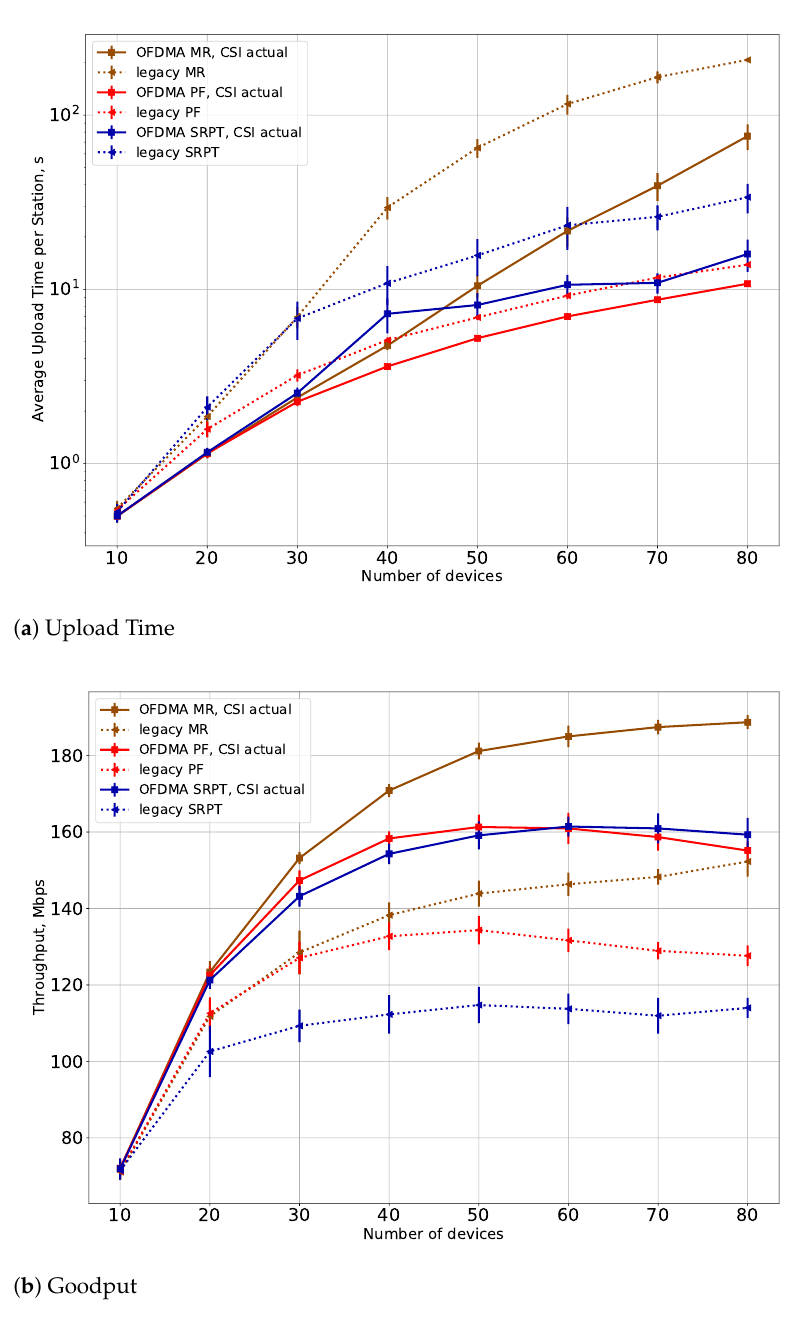
Figure 5. ( a ) Upload time and ( b ) goodput for the proposed schedulers in comparison with the legacy schedulers for high numbers of